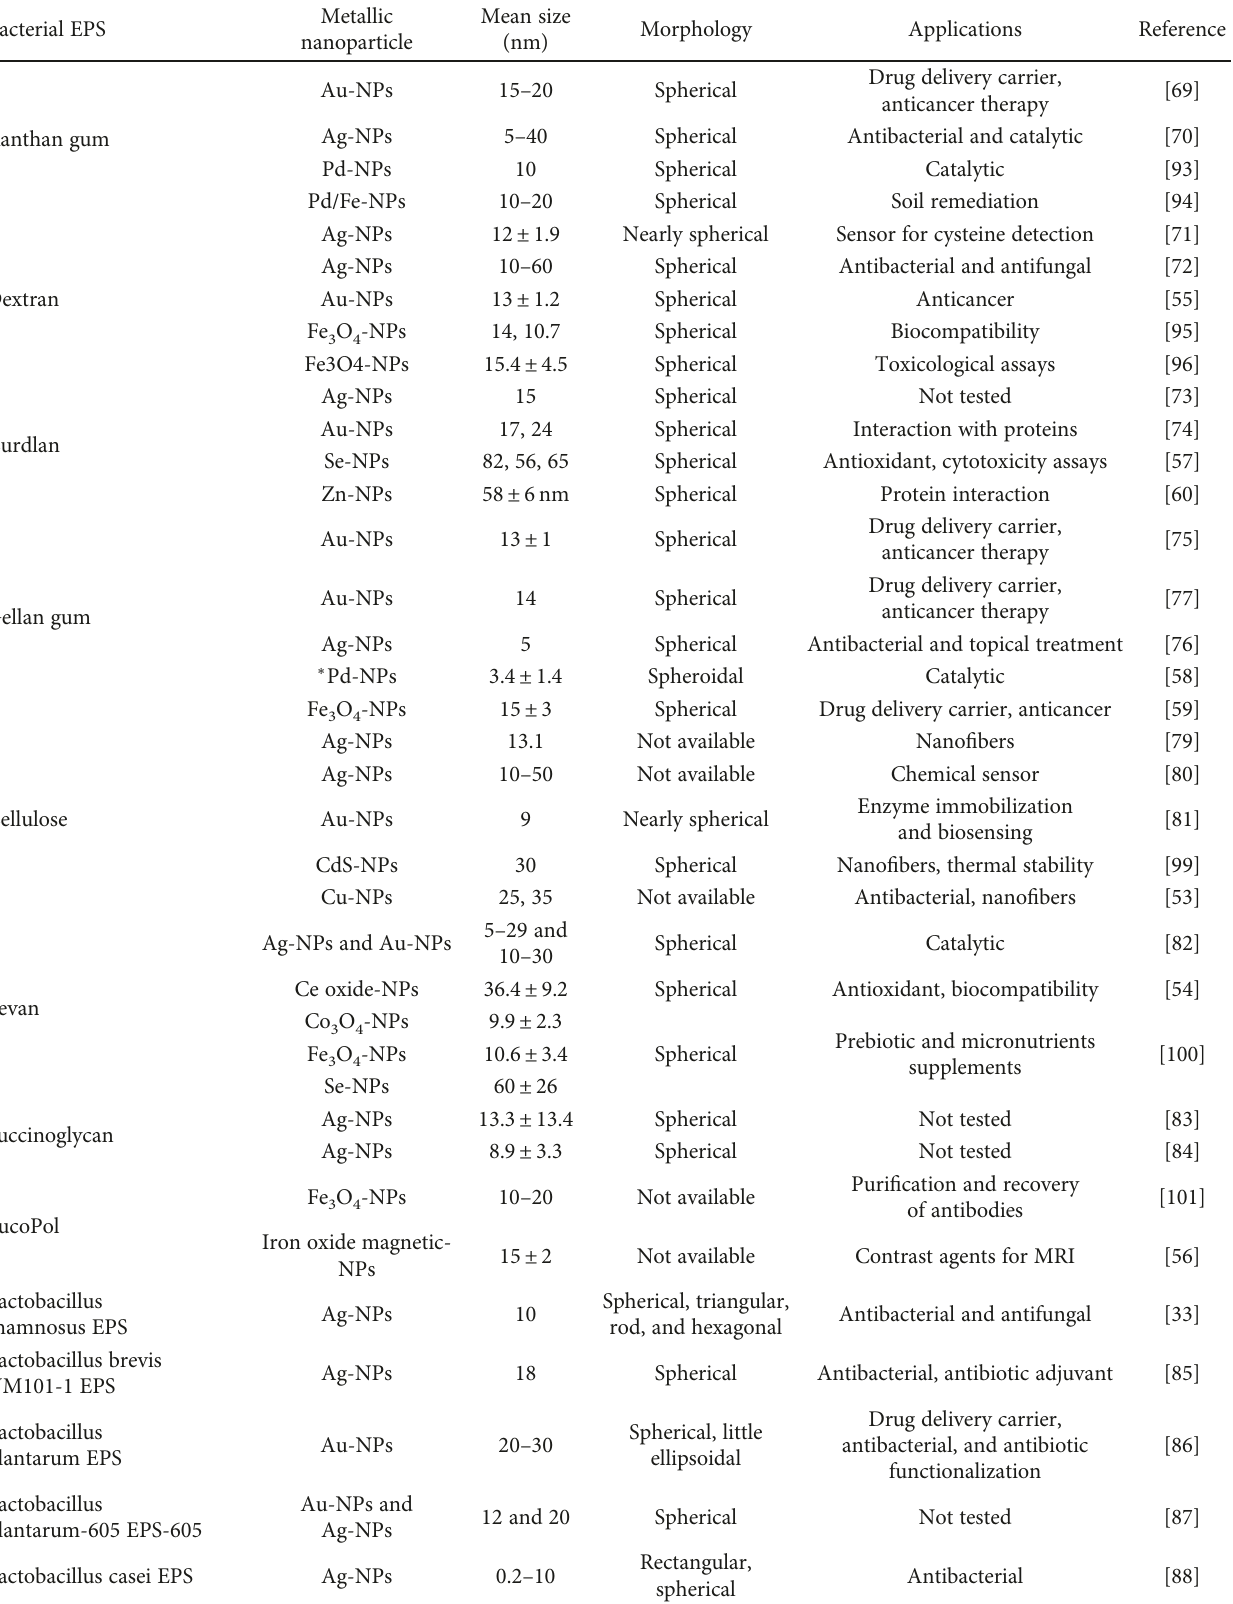
Table 3: Characteristics of metallic nanoparticles synthesized by means of bacterial